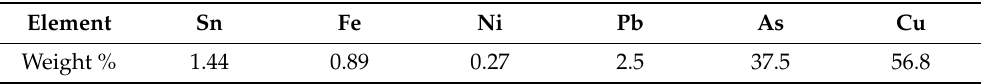
Table 1. Chemical composition of the brass alloy in weight %.